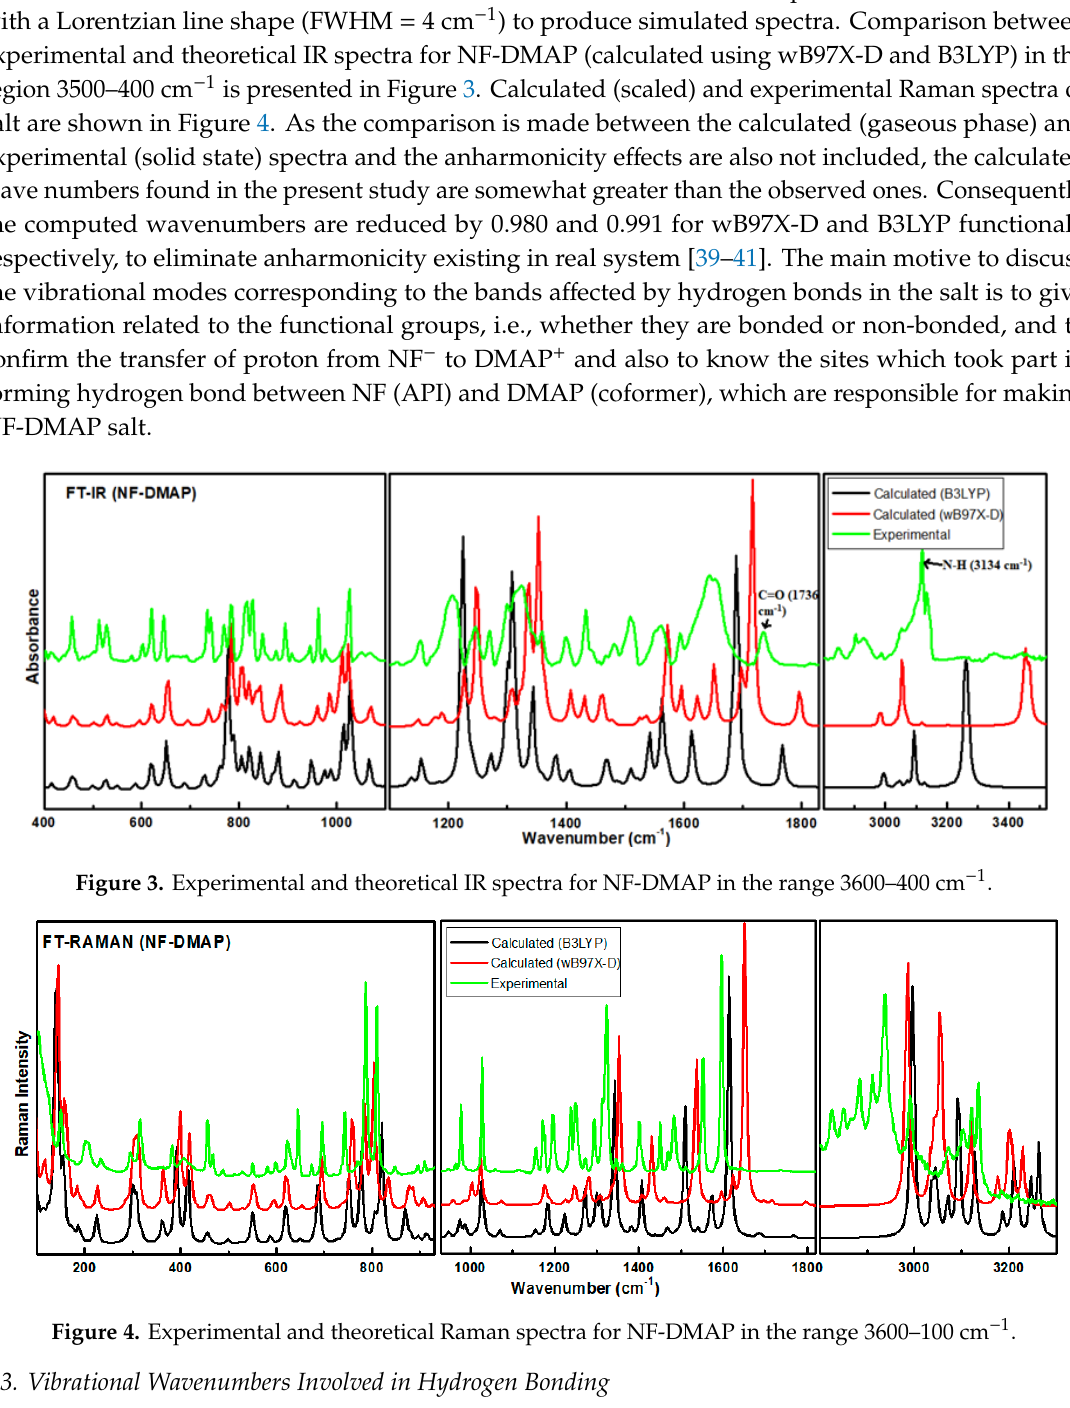
Figure 4. Experimental and theoretical Raman spectra for NF-DMAP in the range 3600–100 cm − 1 .